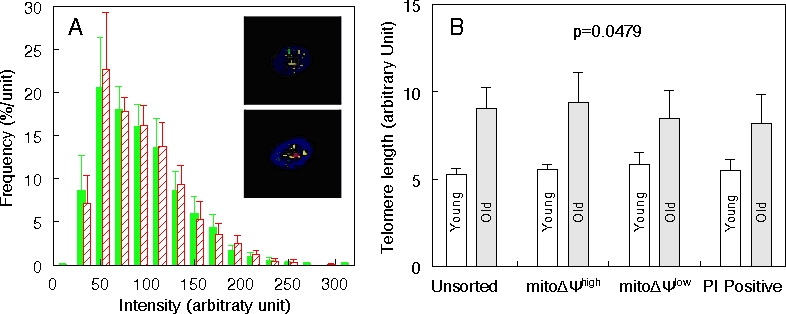
Telomere Signal Intensities by Q-FISH(A) Y and X sperm. Green, Y sperm; red, X sperm; insets display Y sperm (green) and X sperm (red); telomere signal is in yellow.(B) Unsorted and sorted sperm, based on mitochondrial membrane potential (MMP) determined by DiOC6(3) stain. H, high MMP; L, low MMP, Propidium iodide (PI) stained sperm are non-viable. Telomere length (y-axis) denotes the telomere signal intensity in sperm/telomere signal intensity in the reference chicken red blood cells.